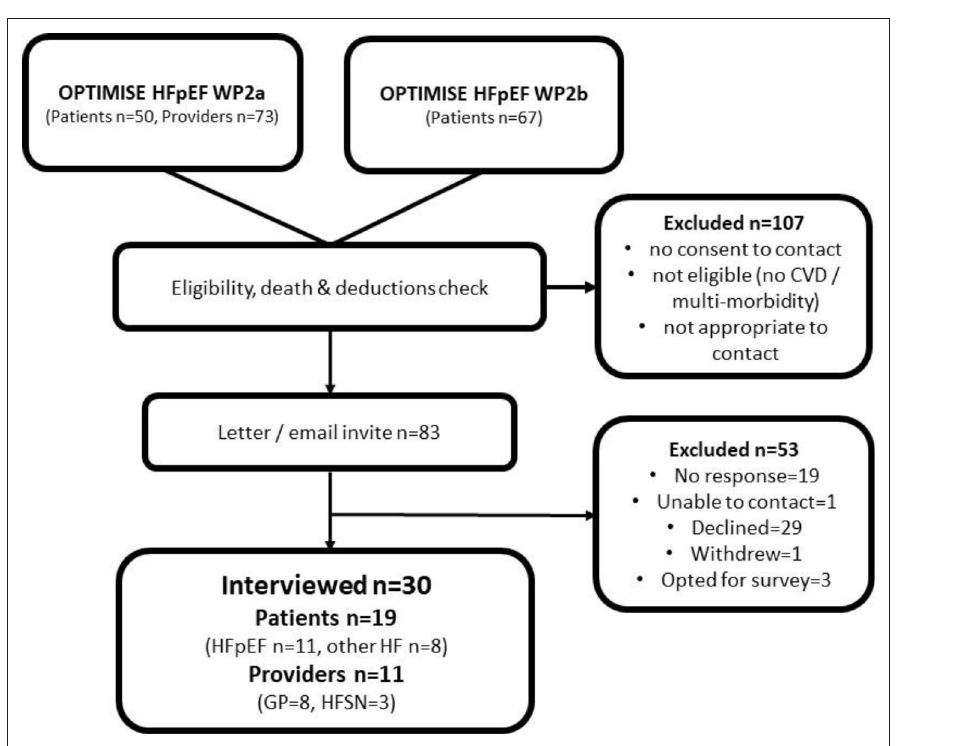
Figure 1 Participant recruitment flow diagram. CVD = cardiovascular disease. HF = heart failure. HFSN = heart failure specialist nurse. OPTIMISE HFpEF = Optimising Management of Heart Failure with Preserved Ejection Fraction in Primary Care. WP = work